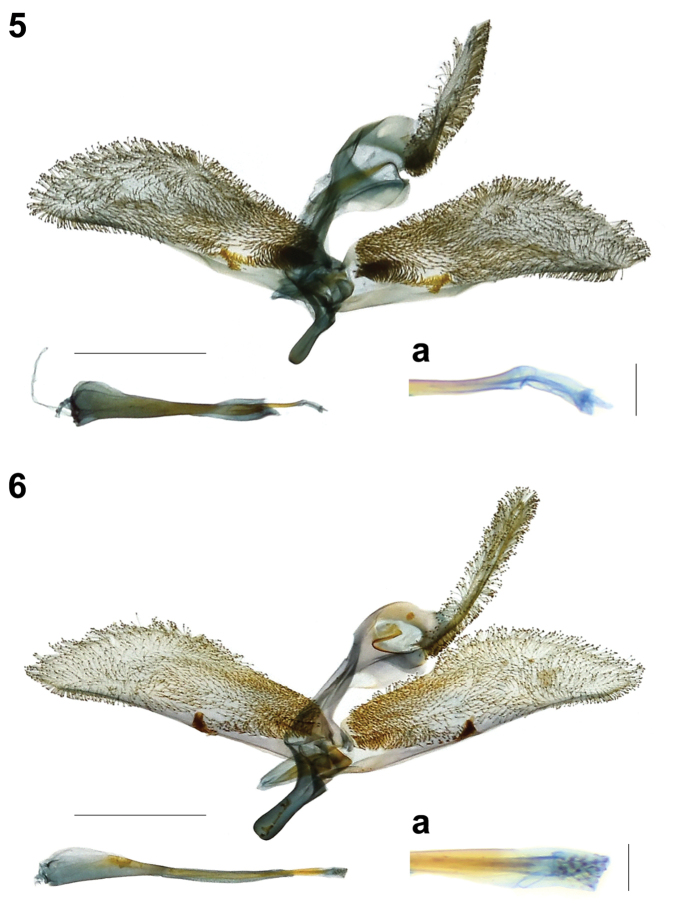
Male genitalia of Synanthedonini. 5Synanthedonauritinctaoidis sp. nov. paratype (NTNU) 5a distal part of phallus. 6Paranthrenellahelvola sp. nov. holotype (NHMUK) 6a distal part of phallus. Scale bars: 1 mm; 0.1 mm (5a, 6a).